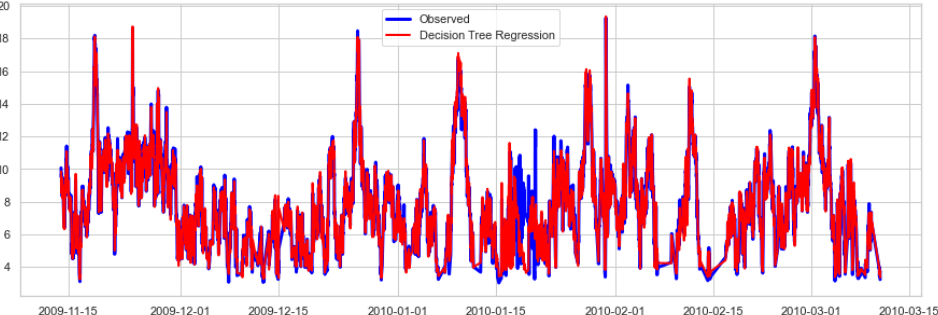
Figure 9. Observed and predicted wind speeds using the RF based only in mesoscale data in ms − 1 . 3.3. Scenario C: Extrapolate Wind Speeds Using Data from a Met Mast and Mesoscale from